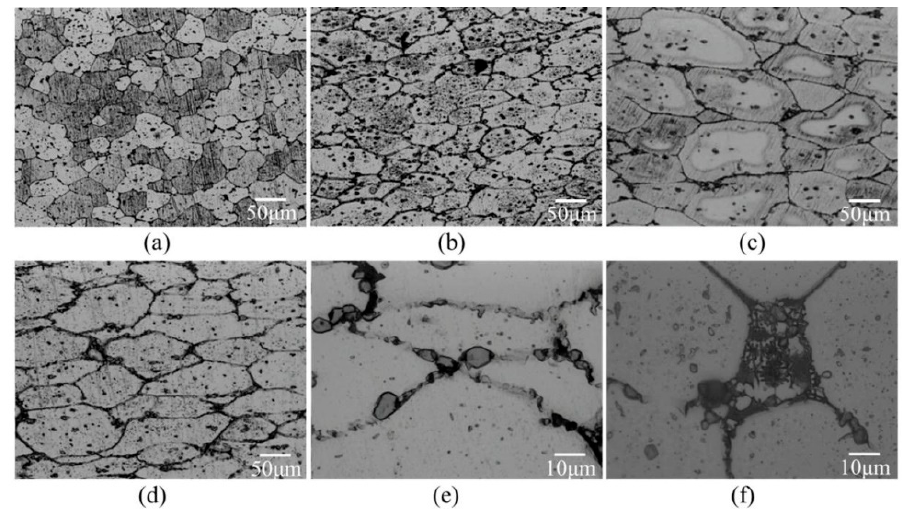
Figure 13. Microstructural characteristics of grain boundaries before and after high-temperature compression ( a ) SB9/620-1 + C550; ( b ) SB9/620-1 + C600; ( c ) SB9/620-30 + C550; ( d ) SB9/620-30 + C600; ( e ) SB9/620-30 + C600 (high magnification); and ( f ) SB9/620-30 (high magnification).